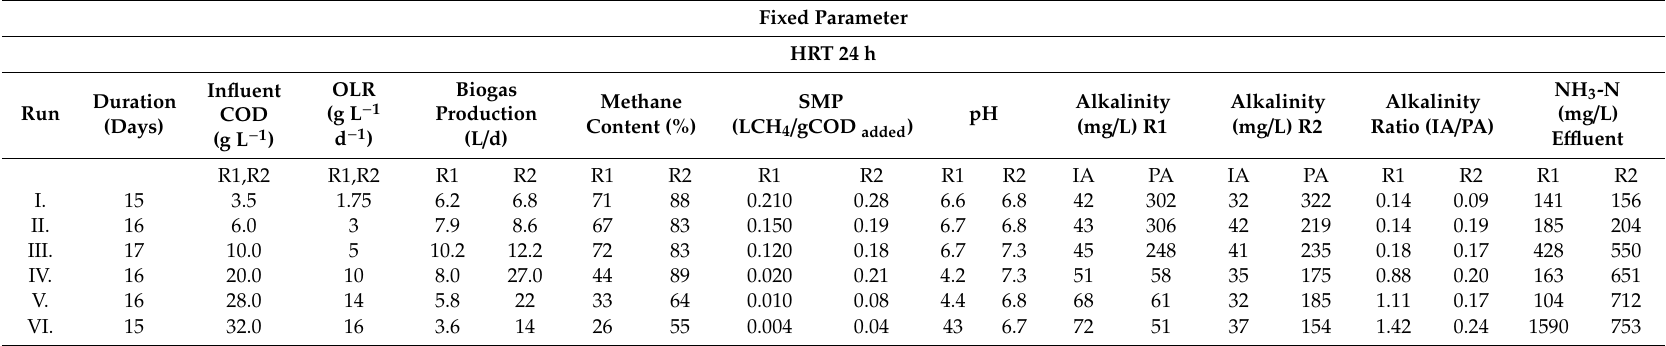
Table 3. Summary of the average steady-state performance comparative study of the conventional (R1) and modified (R2) UASB reactors e ffl uent and biogas production. Fixed